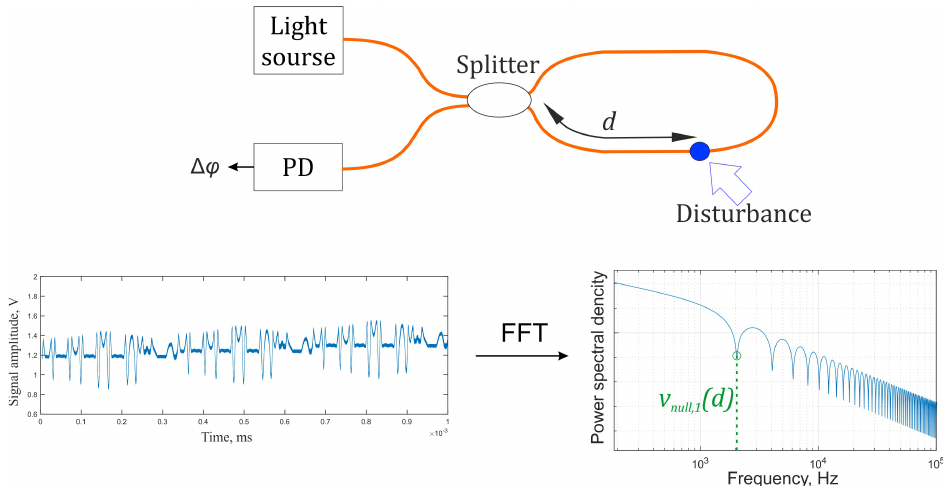
Figure 1. Diagram of a “null frequency” method